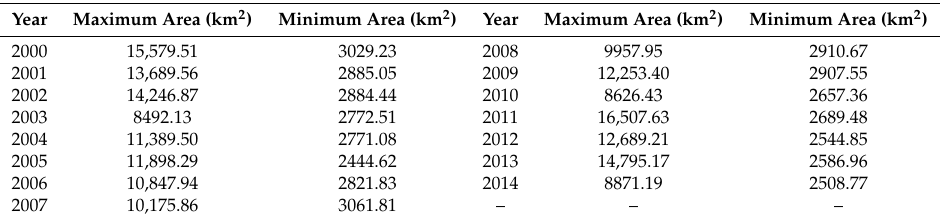
Table 3. Maximum/Minimum Area of Tonle Sap Lake from 2000 to